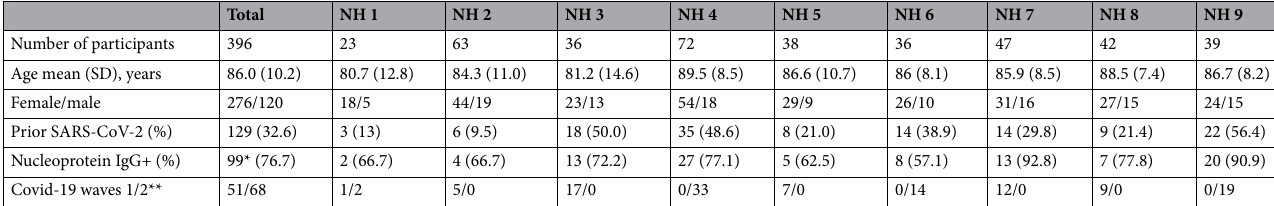
Table 1. Characteristics of the participants. *89 tested positive for SARS-CoV-2 RNA. **COVID-19 proved by